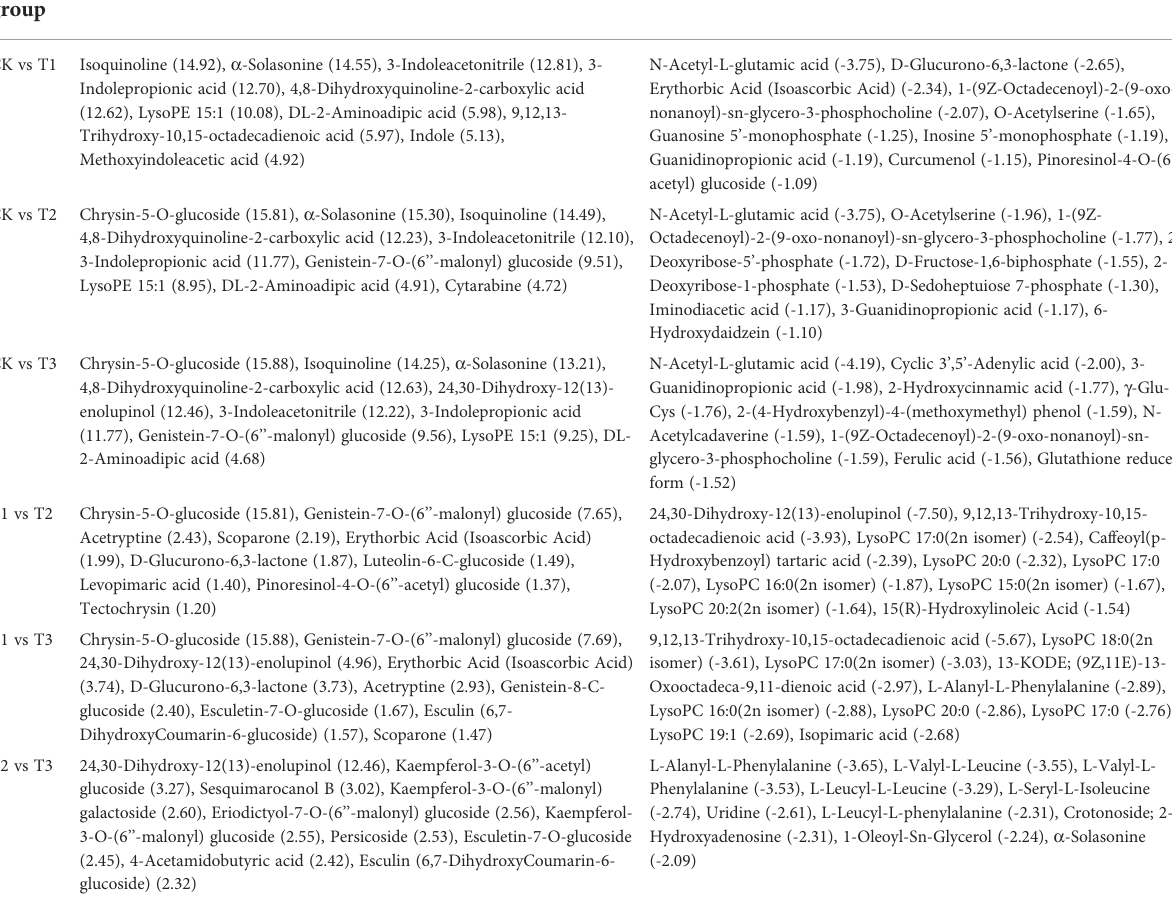
TABLE 1 Top ten DAMs (up or down regulated) among different sample groups. Sample Up-regulated compounds [Log 2 (FC)] Down-regulated compounds [Log 2 group